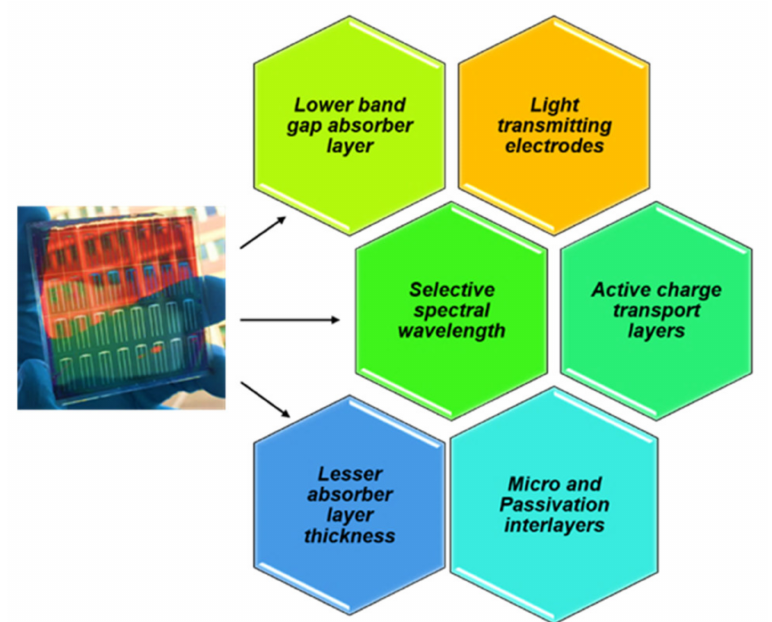
Figure 2. Key takeaways and strategies to attain ST perovskite solar cells